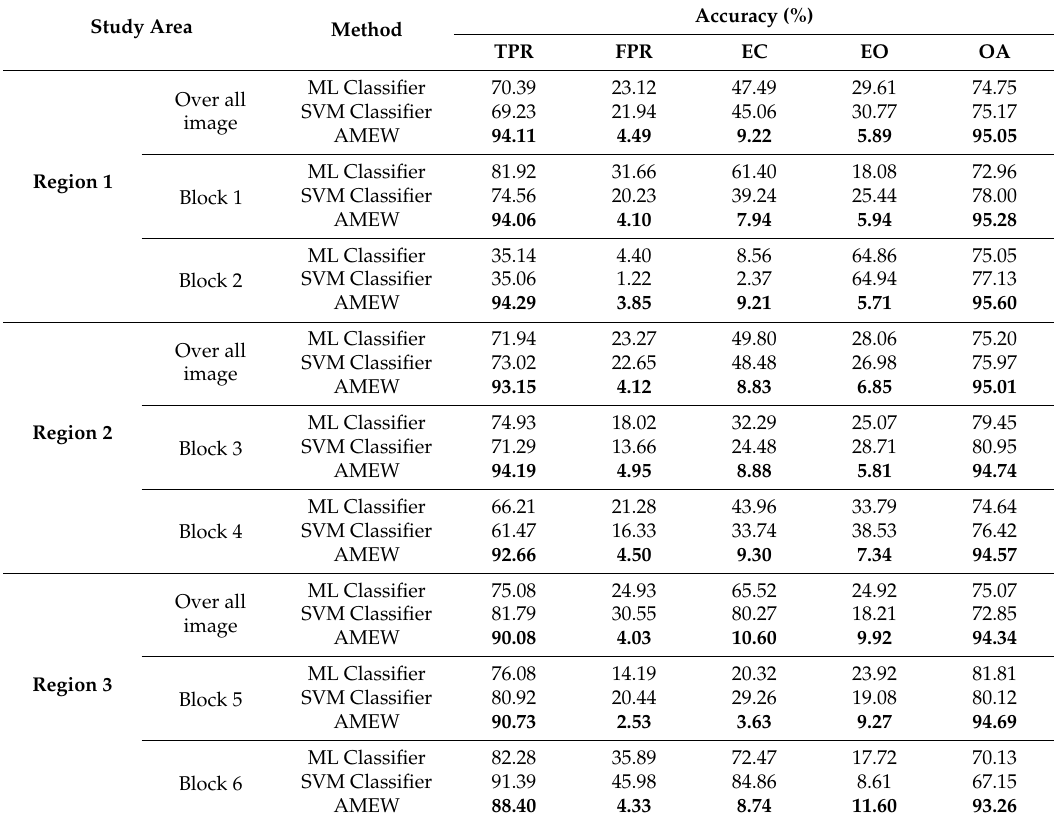
Table 3. Performance evaluation of the ML classifier, the SVM classifier and the